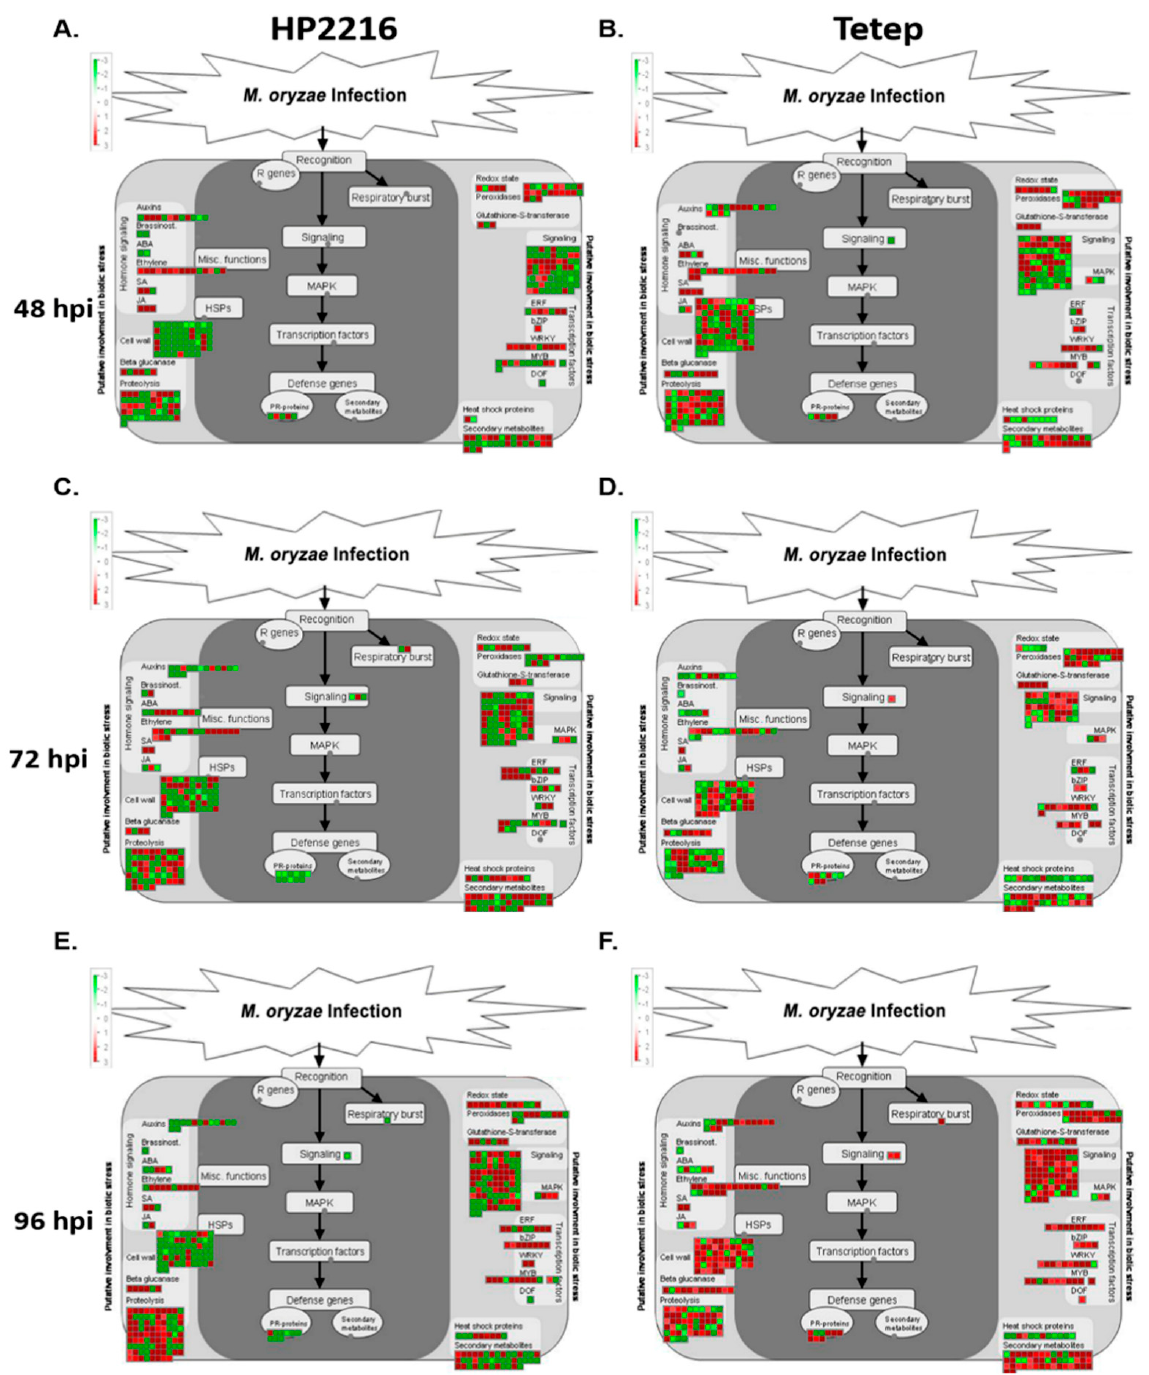
Figure 5. MapMan analysis for significant differentially expressed genes. MapMan overview of significant (FDR adjusted p ≤ 0.05 & log2 fold change ≥ 2) differentially expressed loci (SDEL) involved in biotic stress pathway, in HP2216 and Tetep, at different time intervals of M. oryzae infection. SDEL are binned to MapMan functional categories and values represented as log2 fold change values. ( A , B ) MapMan overview of SDEL in biotic stress pathways in HP2216 and Tetep respectively at 48 hpi. ( C , D ) MapMan overview of SDEL in biotic stress pathways in HP2216 and Tetep respectively at 72 hpi. ( E , F ) MapMan overview of SDEL in biotic stress pathways in HP2216 and Tetep respectively at 96 hpi. Red color represents up- regulated loci and green represents down-regulated loci.ABA, abscisic acid; JA, jasmonic acid; SA, salicylic acid; HSPs, heat shock proteins; R genes, resistance genes; ERF, ethylene response factor; bZIP, basic region-leucine zipper; WRKY, WRKY family of transcription factors; MYB, myeloblastosis family of transcription factors; DOF, DNA-binding with one finger plant specific transcription factors; MAPK, mitogen-activated protein kinase; PR-protein, pathogenesis-related